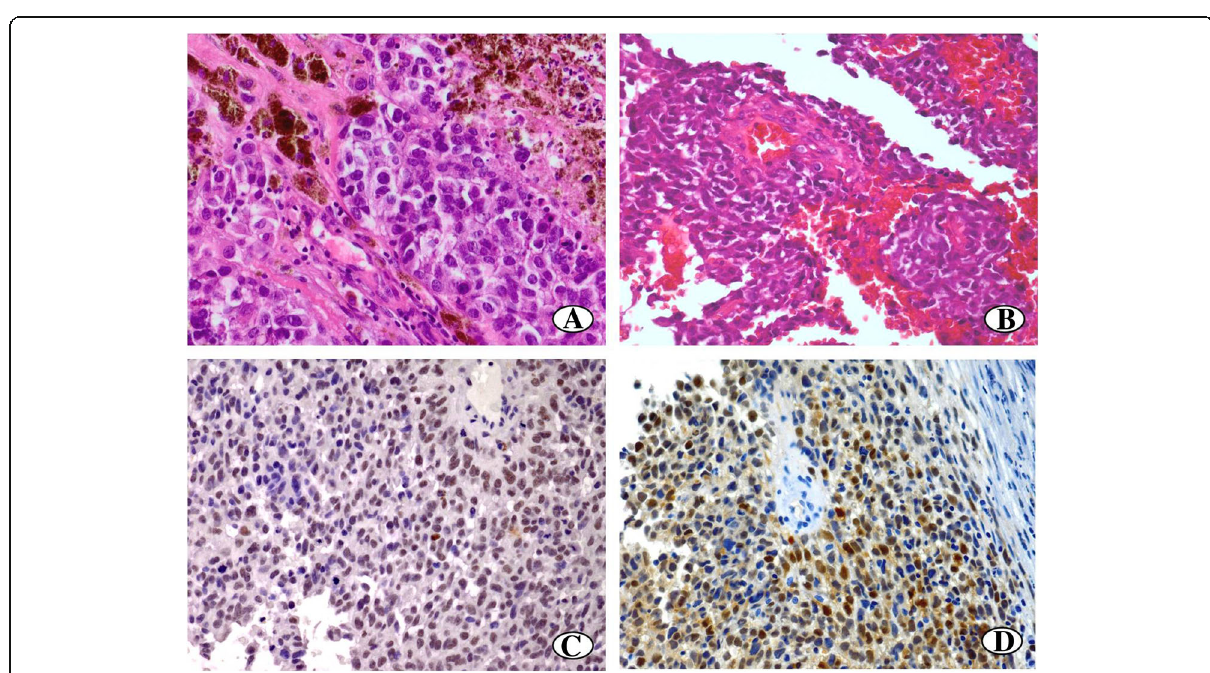
Fig. 1 Sinonasal melanoma: a and b – histopathological features: tumor composed of small undifferentiated cells ( a ), which form a cuff surrounding a blood vessel (peritheliomatous arrangement). c and d – immunohistochemical findings: nuclear expression for Bmi-1 ( c ) and nuclear and cytoplasmic expression for p16 ( d ) are seen in most tumor